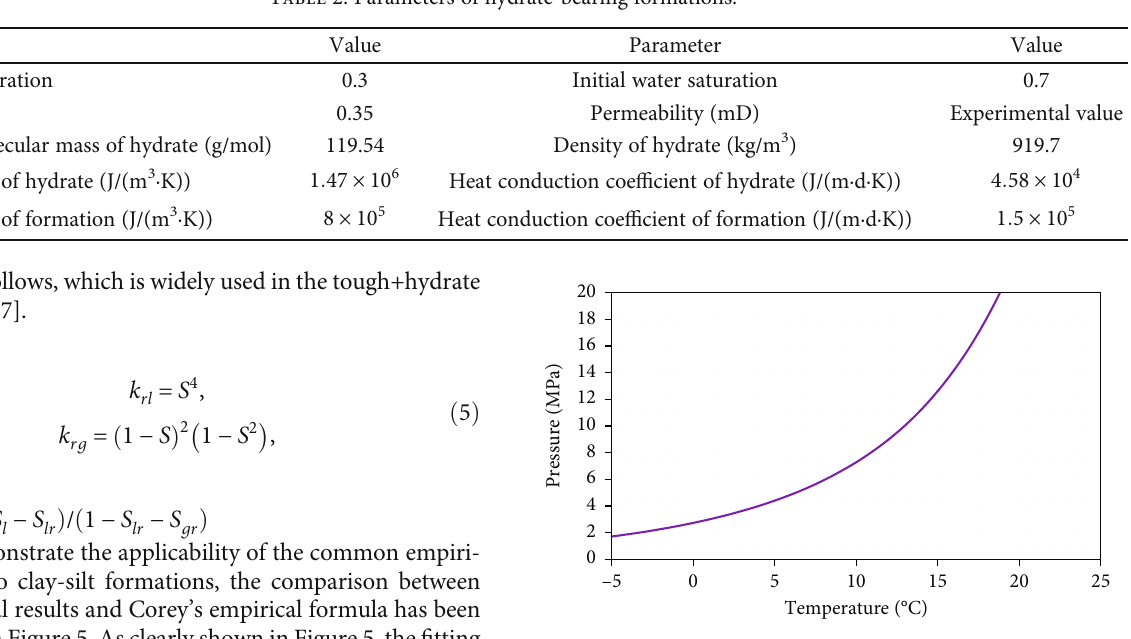
Figure 7: Phase equilibrium curve of methane